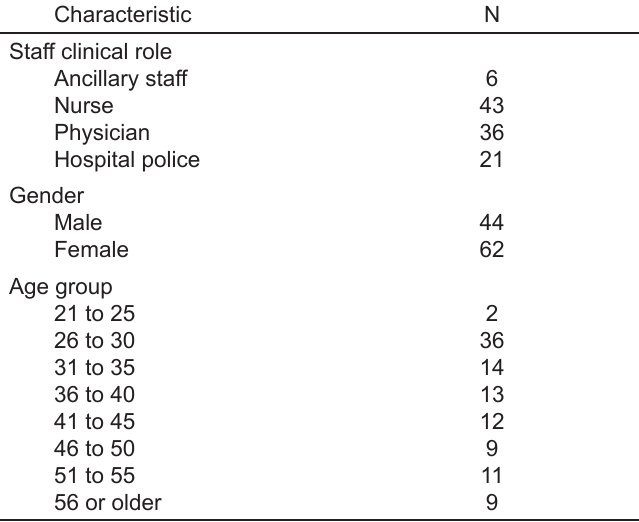
Table. Survey respondent